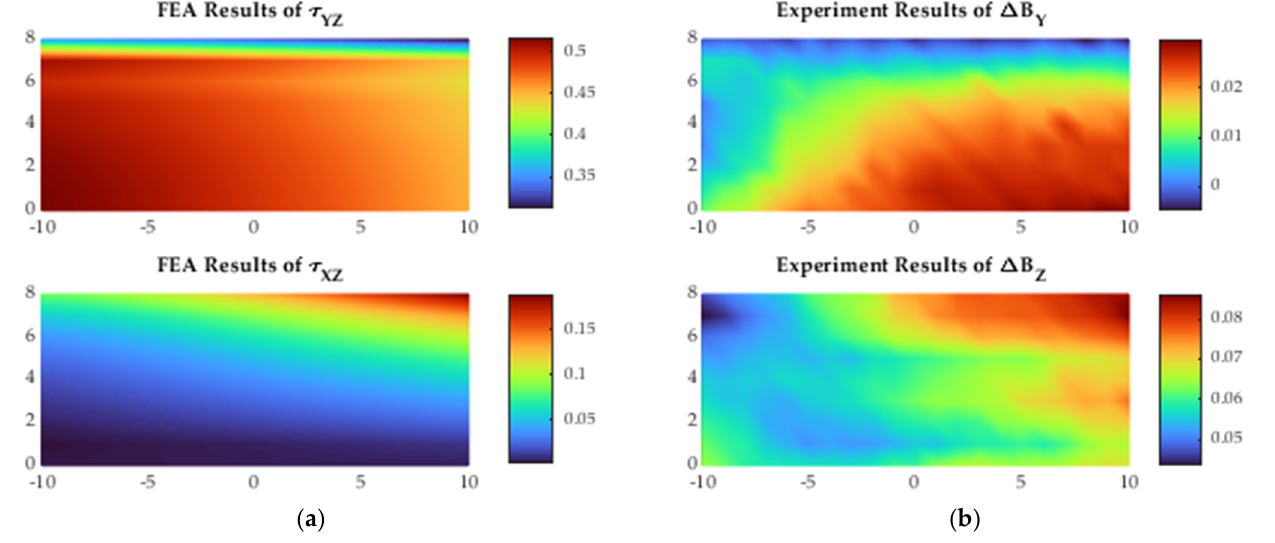
Figure 7. FEM analysis and experimental measurements of the area of interest of the SA 106 plate: ( a ) FEM analysis of the stresses ( σ X , σ Y , and σ Z ) and shear stresses ( τ XY , τ YZ , and τ XZ ); ( b ) distribu- tion of the of the magnetic flux density ( B X , B Y , and B Z ) and the subtracted magnetic flux density ( ∆ B X , ∆ B Y , and ∆ B Z